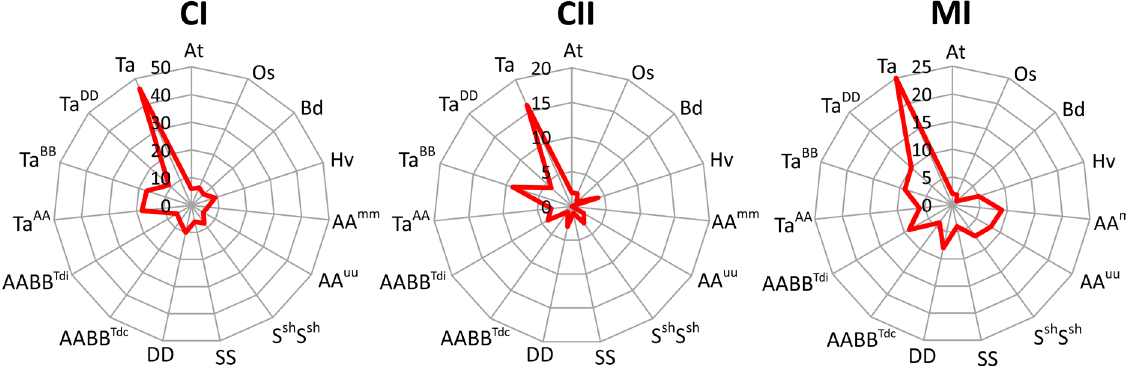
Figure 2. Copy number variation of CI, CII and MI subfamily during wheat polyploidization. Abbreviations, At, Arabidopsis thaliana ; Os, Oryza sativa ; Bd, Brachypodium distachyon ; Hv, Hordeum vulgare ; AA mm , Triticum monococcum ; AA uu , Triticum urartu ; S sh S sh , Aegilops sharonensis ; SS, Aegilops speltoides ; DD, Aegilops tauschii ; AABB Tdc , Triticum durum , cv. Strongfield; AABB Tdi , Triticum durum , cv. Cappelli; Ta AA , subgenome A of bread wheat; Ta BB , subgenome B of bread wheat; Ta DD , subgenome D of bread wheat; Ta, Triticum aestivum